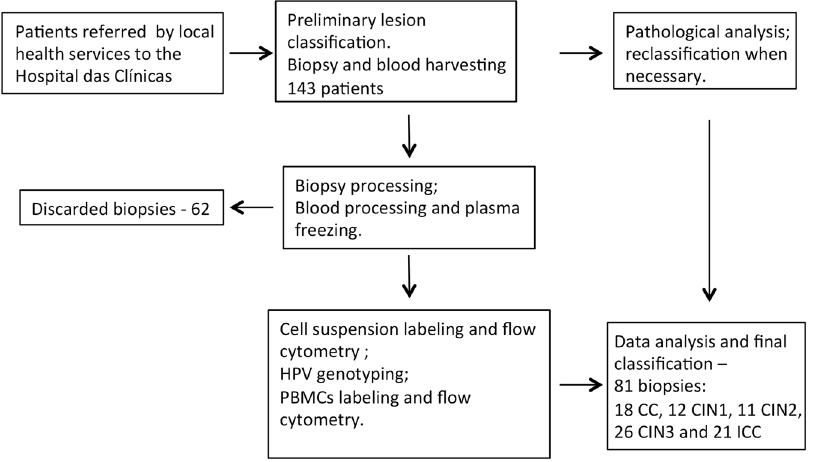
Figure 1. Organogram of cohort enrolment. Patients with cytology indicative of HPV associated lesion were referred to Hospital das Clínicas. A total of 143 patients were enrolled with colposcopy suspicious of cervical lesion. Biopsies and peripheral blood were processed and if we obtained enough cells from biopsies, these cells were labeled with antibodies to continue the study, if not, only the blood sample was saved.